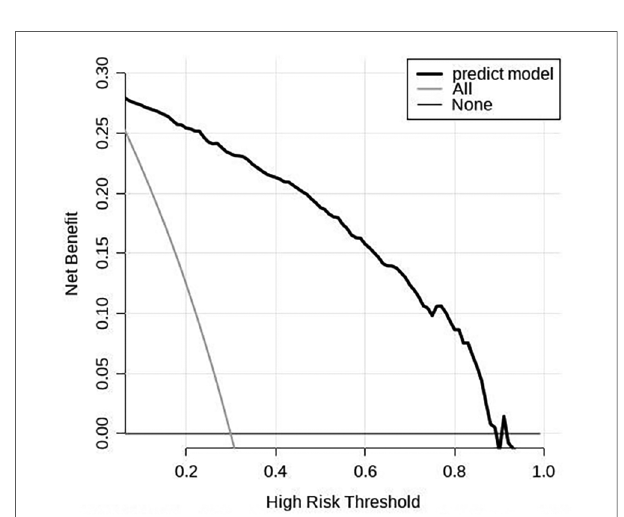
FIGURE 7 Clinical decision analysis curve of the training set. The DCA curve showed that using the model to predict the development of GH to PE produced more bene fi t when the probability of PE between 0.01 and